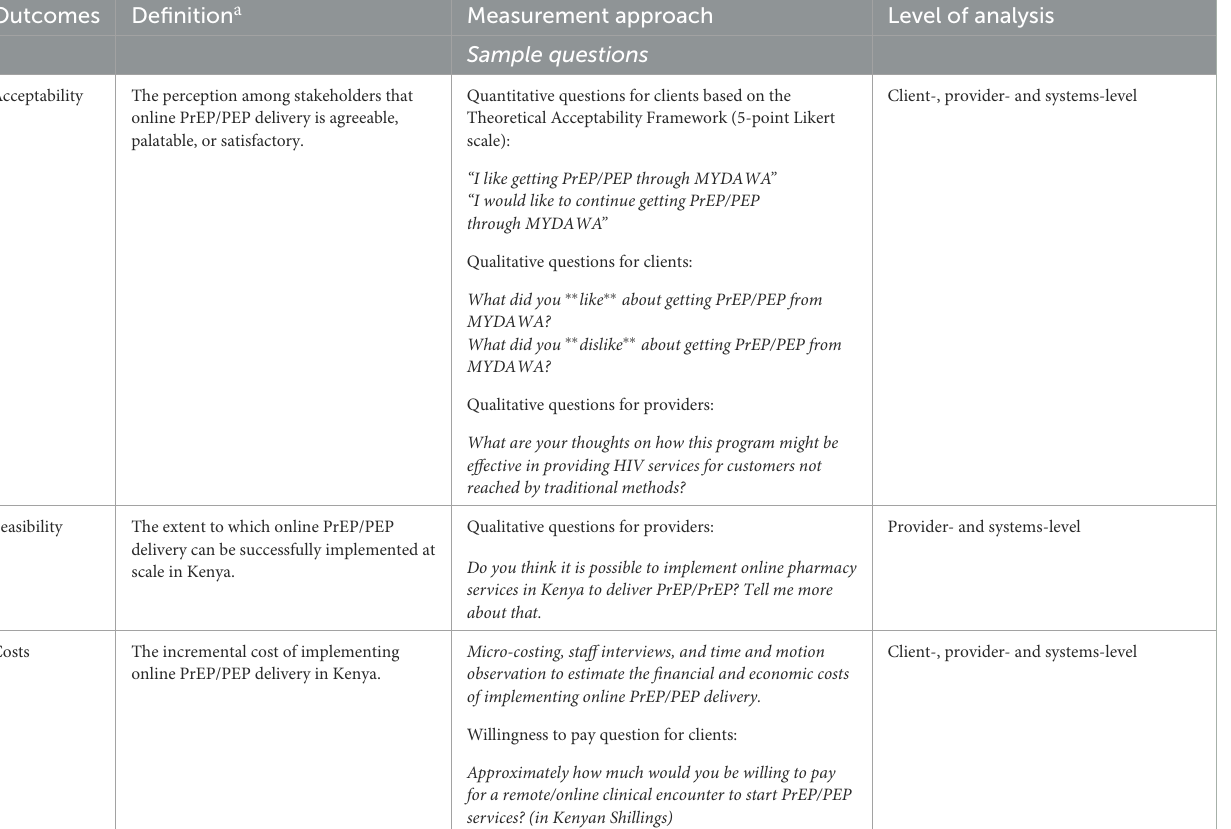
TABLE 3 Description of implementation outcome measures in the pilot